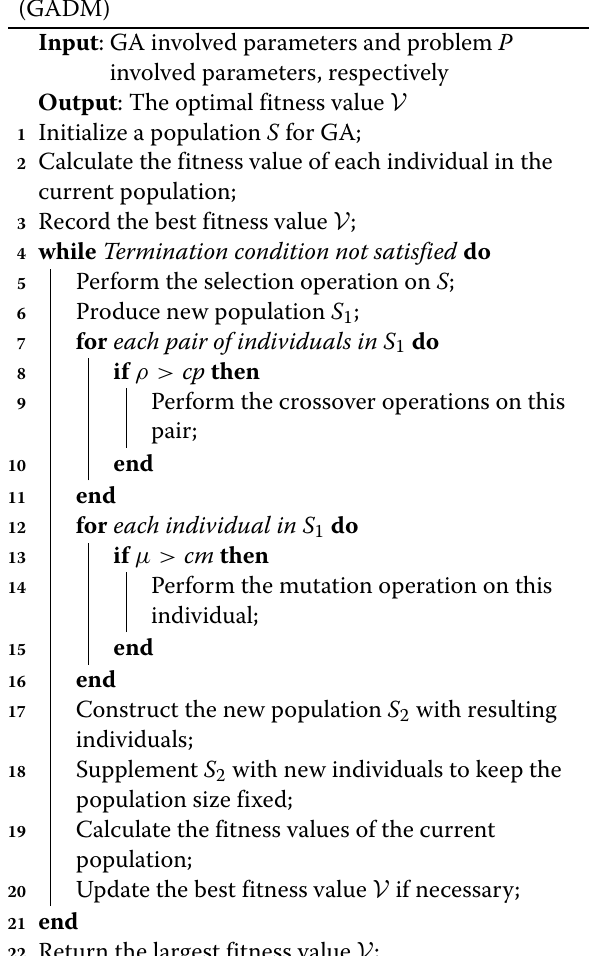
Algorithm 1: GA based decision making algorithm